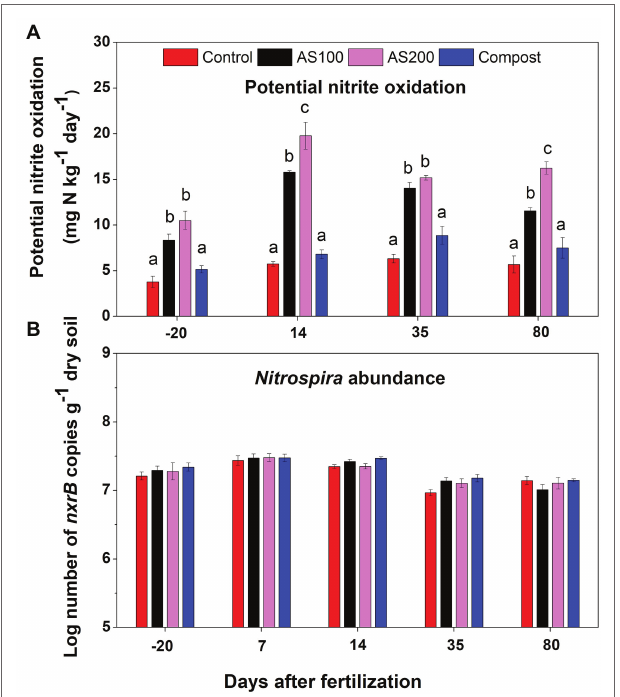
FIGURE 1 | (A) Nitrite oxidation potentials in 2015 before and after fertilization across four Nitrogen (N) treatments [control (no N fertilization), ammonium sulfate (AS 100 and 200 kg N ha −1 ), and compost (200 kg N ha −1 )]. Nitrite oxidation potential was measured by soil slurry assay supplemented with 0.15 mM NO 2− . Error bars represent standard errors ( n = 4). Different letters above the bars indicate a significant difference among treatments within a specific sampling time ( p < 0.05) based on repeated measures ANOVA. (B) Abundance of Nitrospira nxrB gene copy numbers (log 10 transformed) across four N treatments. Error bars represent standard errors ( n = 4).